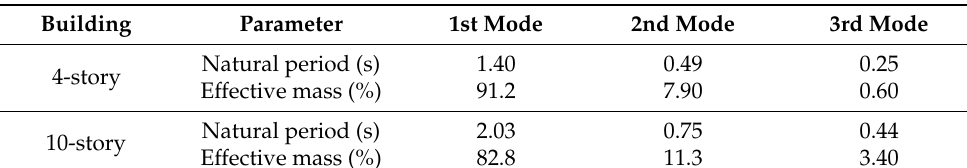
Table 7. Dynamic characteristics of target buildings.